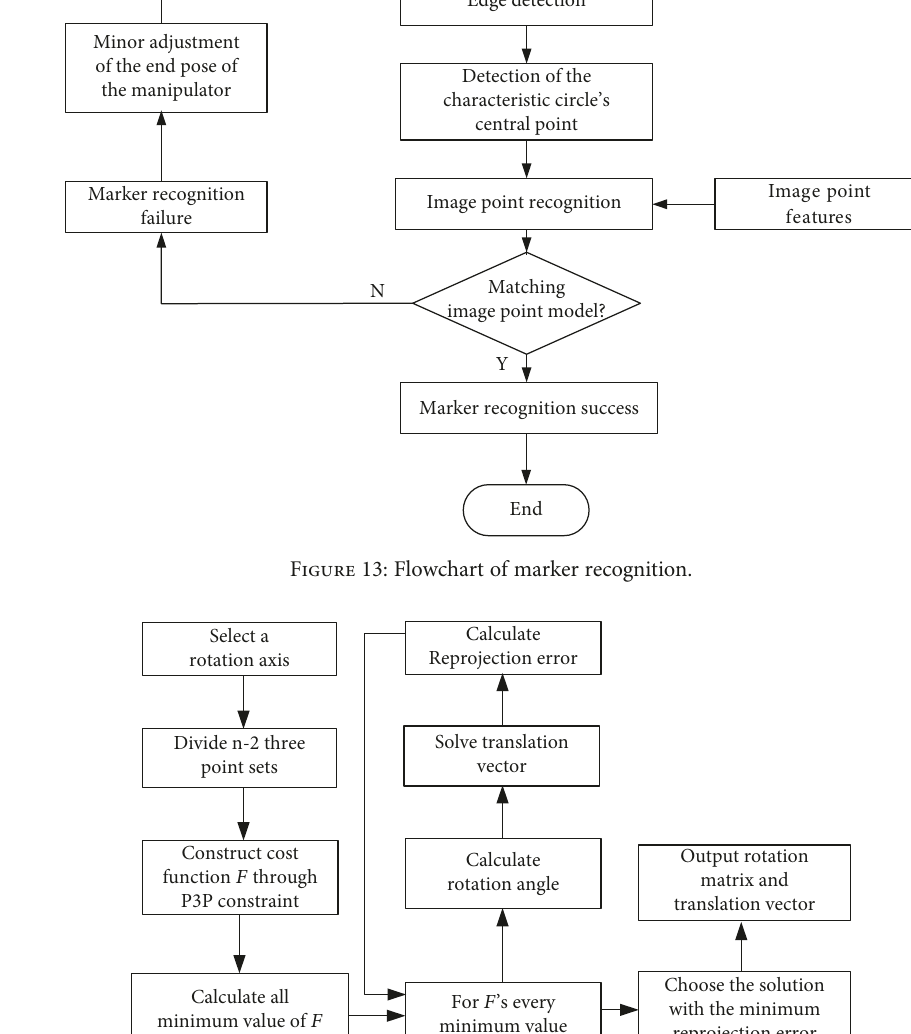
Figure 14: Flowchart of the RPNP